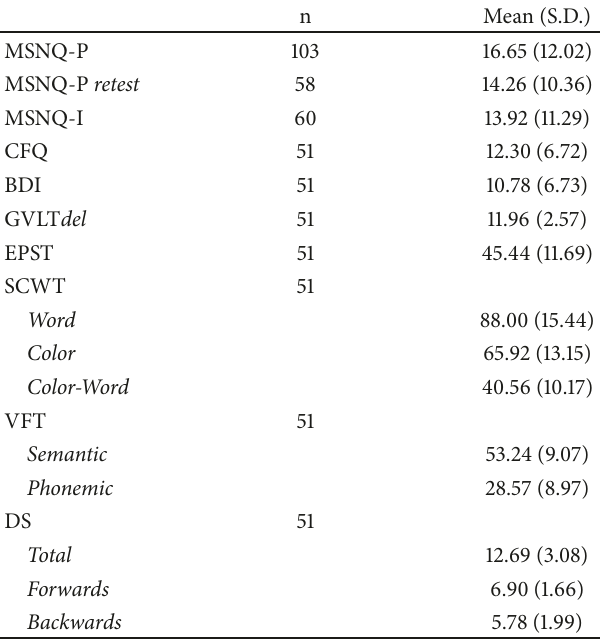
Table 2: Descriptive information for MS